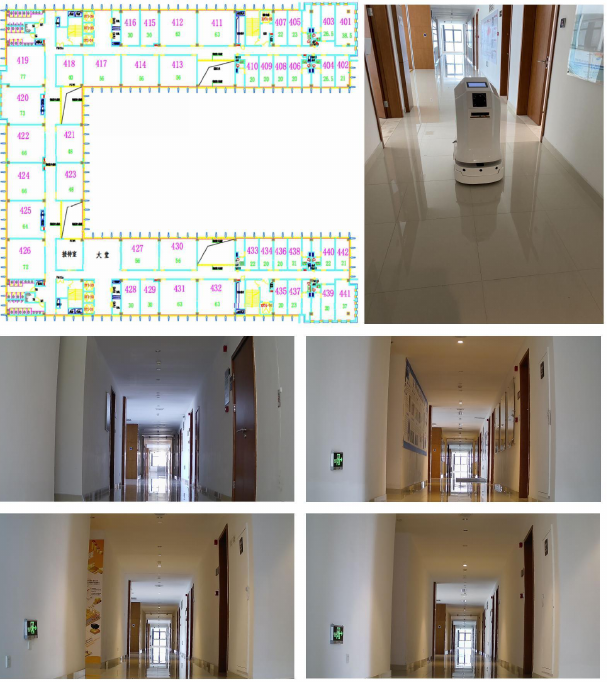
Figure 6. The layout of the experimental corridor environment, the mobile robot constructing DB W and DB I , automatically, and several image samples from DB I .